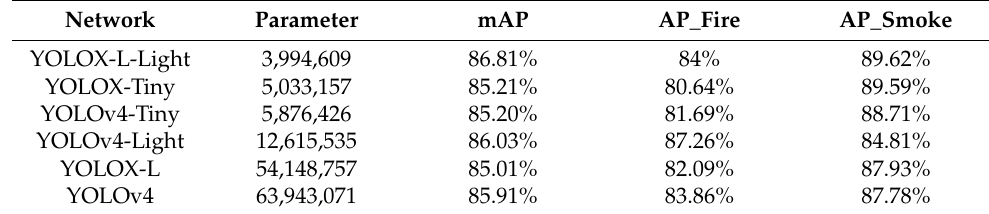
Table 7. Comparison of the performance of different CNN models.